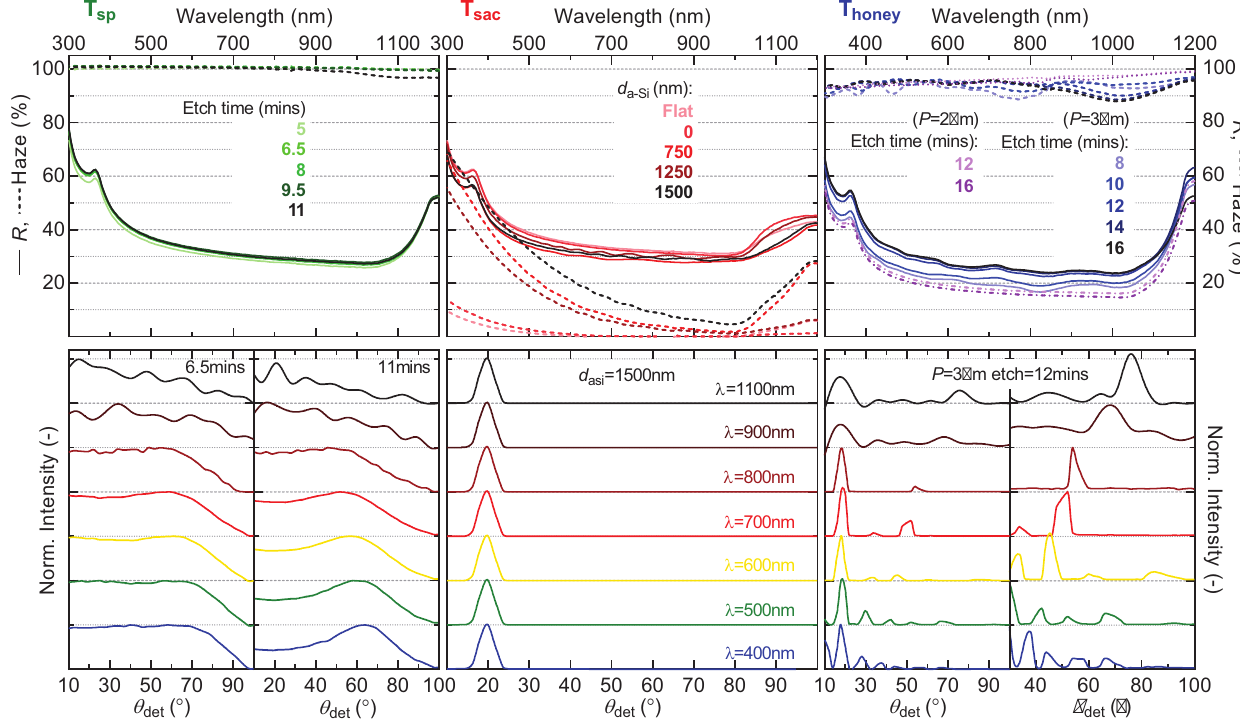
Fig. 10. Re fl ective behaviour of T sp (green, left), T sac (red, centre) and T honey (blue, right). Presented are R (top, solid lines) and H R (top, dashed lines) and AID (bottom). AID measurements show normalized intensity (normalized to maximum value) as a function of detector angle ( u det ) in reference to the incident light, with the sample positioned at a 10 degree angle, for different wavelengths ( l ). For T sp , R and H R are shown as a function of etching time and AID measurements are shown for samples etched at 6.5mins (left) and 11 mins (right). For T sac , R and H R are shown as a function of d asi . R and H R of a fl at, polished wafer is included as reference. AID measurements are shown for the sample with d asi = 1500nm. For T honey , R and H R are shown as a function of etching time (step 4) for honeycombs with p=2 m m ( R = dashed/dotted, H R =dotted) and p=3 m m ( R =solid, H R =dashed). AID measurements are shown for samples with p=3 m m etched for 12mins, with right image showing AID normalized to max value in u det = 30 (cid:1) – 90 (cid:1)